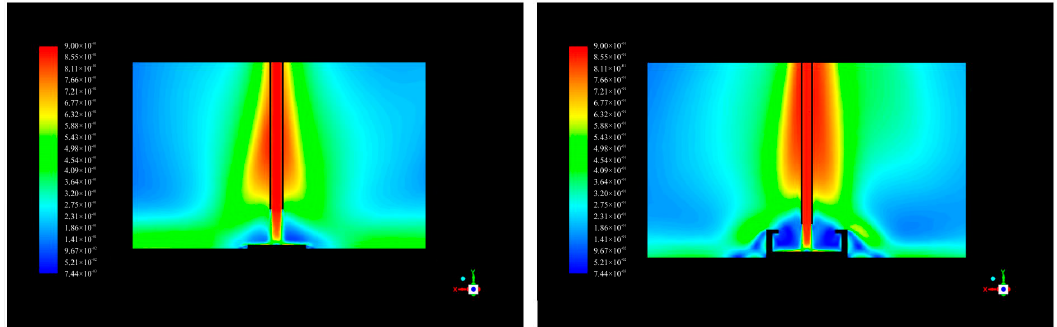
Figure 11. Comparison of velocity areas for “Spheric” and standard impact pads @ 1.2 m · min − 1 .